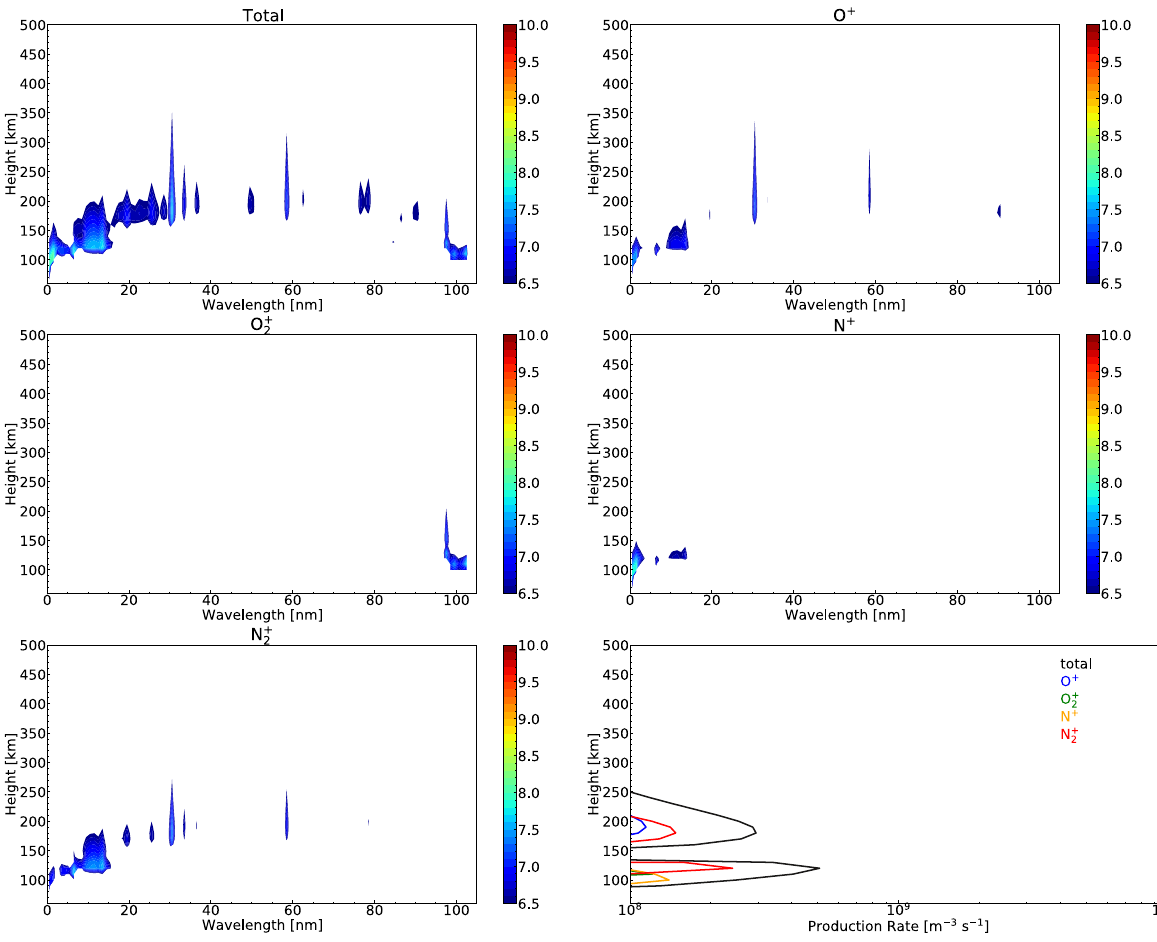
Fig. 5 Differences in ion production rate between the pre-flare and flare peak by GAIA with RUN-Ff. Differences in ion production rate between the pre-flare and flare peak at 130°E and 34°N calculated by GAIA with RUN-Ff for the X1.1 class flare that occurred on November 8, 2013. Differences in the ionization rates for a total ion, b O + , c O 2 + , d N + , e N 2 + as a function of the wavelength of solar emission (unit: Log10 (W m − 2 nm − 1 ). f Differences in the altitude distribution of the ionization rates of each ion. The solid and dotted lines indicate the ionization rates of each ion at the flare peak (4:24 UT) and the pre-flare (4:00 UT),